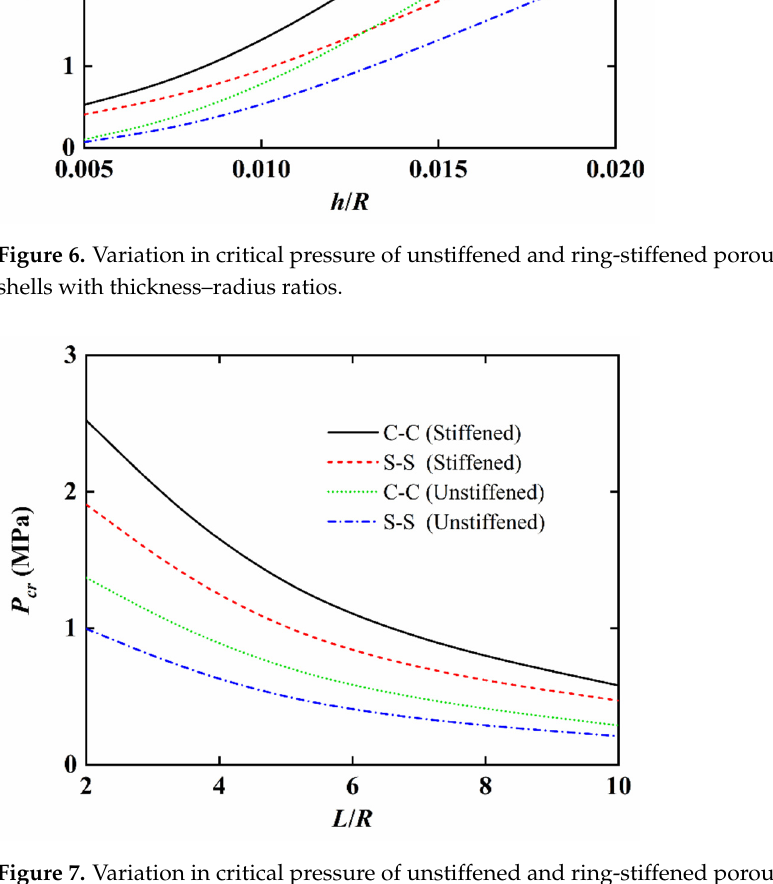
Figure 7. Variation in critical pressure of unstiffened and ring-stiffened porous GPLRC cylindrical shells with length–radius ratios.